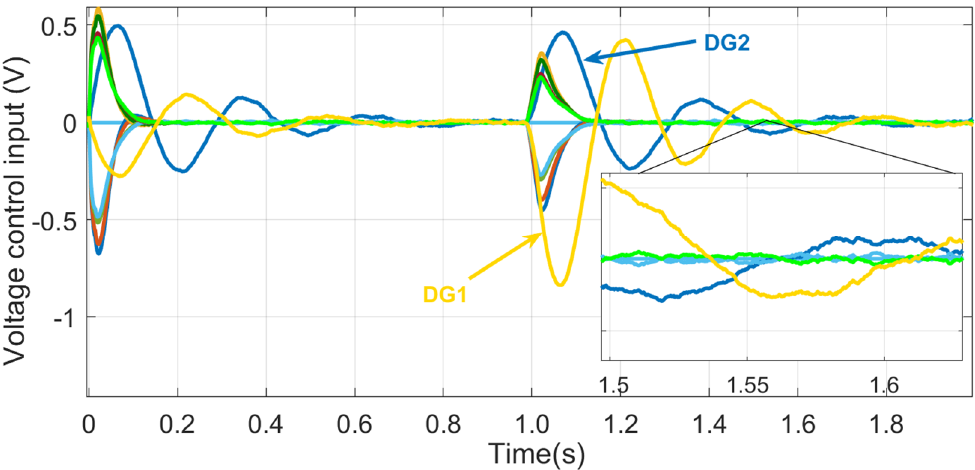
Figure 12. Control input with periodic communication with time delay τ = 80 ms